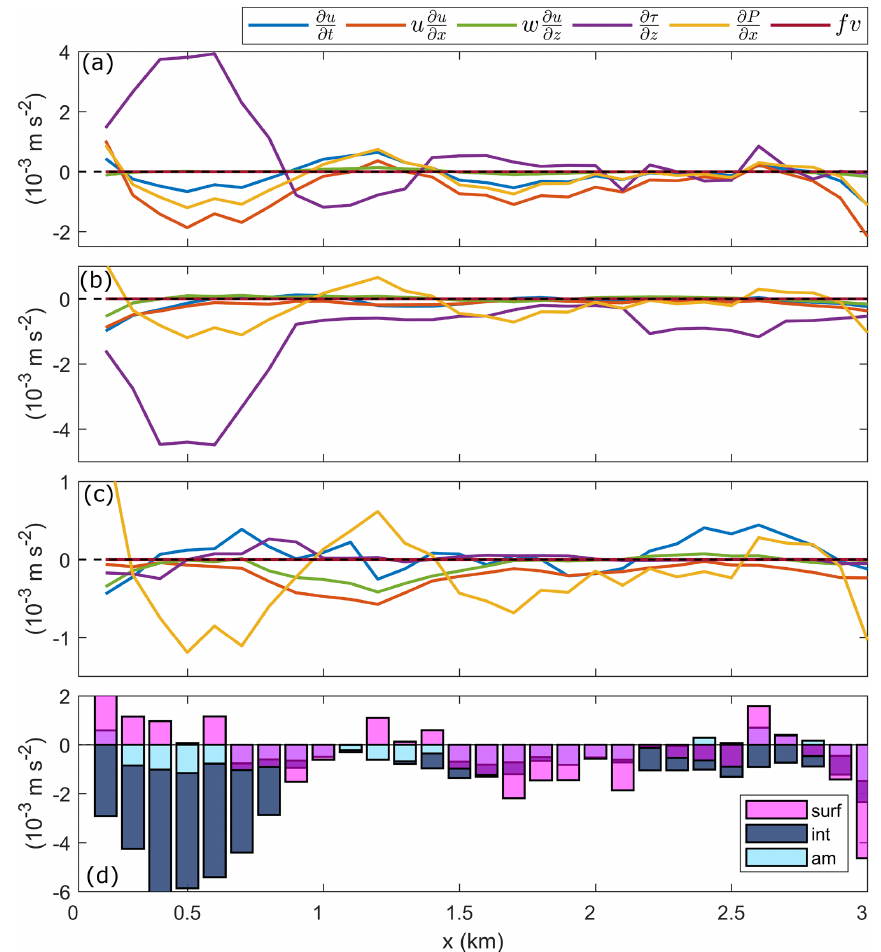
Figure 9. The individual and sum of all the layer-averaged terms in the along-channel momentum budget. The budget terms were averaged over the depth of (a) the plume (0 ≤ z < 2m), (b) the interface (2 ≤ z < h m), where h is defined in Fig. 6b, and (c) the ambient below the surface layer ( h ≤ z < 10m). (d) The sum of all the layer-averaged momentum components within the surface (pink) and interfacial (dark blue) layers, and the ambient (light blue). Horizontal dashed lines indicate zero, where the budget is completely balanced.